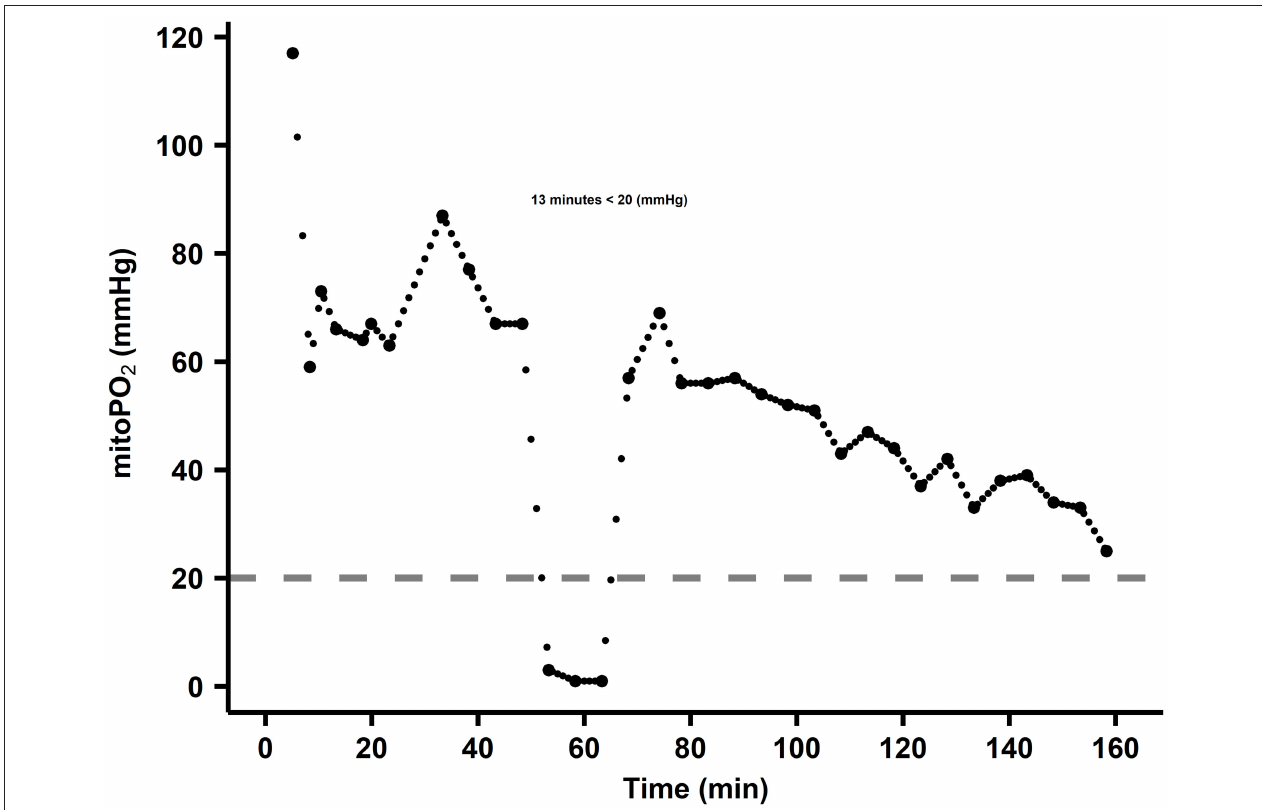
FIGURE 7 | Example of minutes below threshold calculation. The dots are cutaneous mitoPO 2 values, and the dashed line is the threshold set at 20mmHg. In this case, the cutaneous mitoPO 2 was below the threshold for